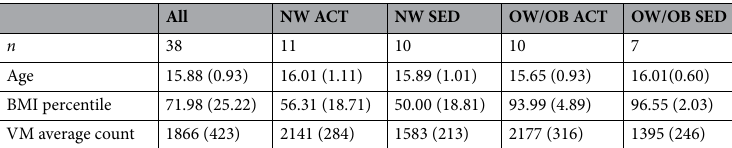
Table 1. Descriptive statistics ( n = 38). Mean and standard